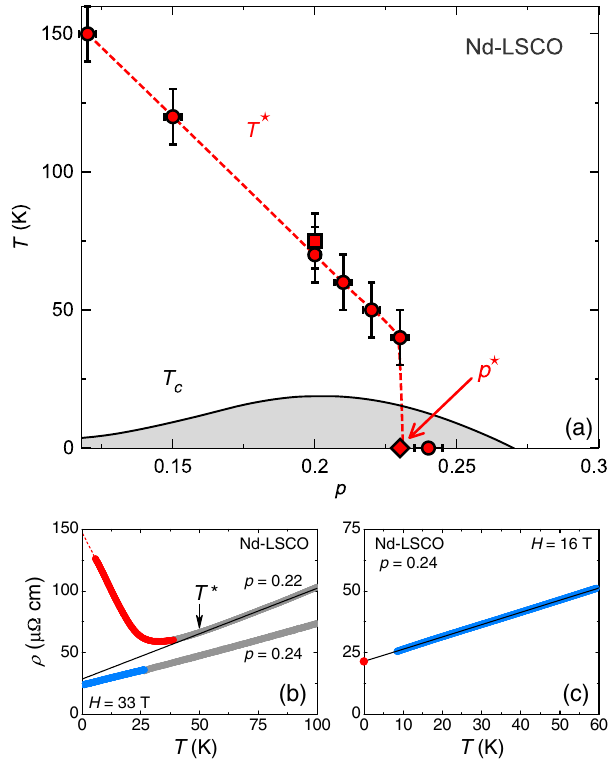
FIG. 1. (a) Temperature-doping phase diagram of Nd-LSCO, showing the superconducting T c (gray dome) and the pseudogap temperature T ⋆ extracted from the electrical resistivity (red dots, Ref. [19]) and from angle-resolved photoemission spectroscopy (red square,Ref.[20]).Thereddiamondmarksthepositionof p ⋆ ¼ 0 . 23 , the doping for the onset of the pseudogap phase in Nd-LSCO. The red dashed line is a guide to the eye. (b) Electrical resistivity vs temperature for Nd-LSCO at p ¼ 0 . 22 and 0.24, at H ¼ 0 (gray data) and in the normal state at H ¼ 33 T (colored). The pseudogap temperature T ⋆ (arrow) is defined as the temperature below which ρ ð T Þ deviates from its T -linear behavior at high temperature (black line). Here, T ⋆ ¼ 50 K at p ¼ 0 . 22 , and T ⋆ ¼ 0 at p ¼ 0 . 24 . (c) Electrical resistivity of Nd-LSCO at p ¼ 0 . 24 and H ¼ 16 T (blue) with a linear fit (black line). The red dot is L 0 = ð κ 0 =T Þ , with κ =T measured in the same sample at H ¼ 15 T (Fig. 2), showing 0 that the Wiedemann-Franz law is perfectly